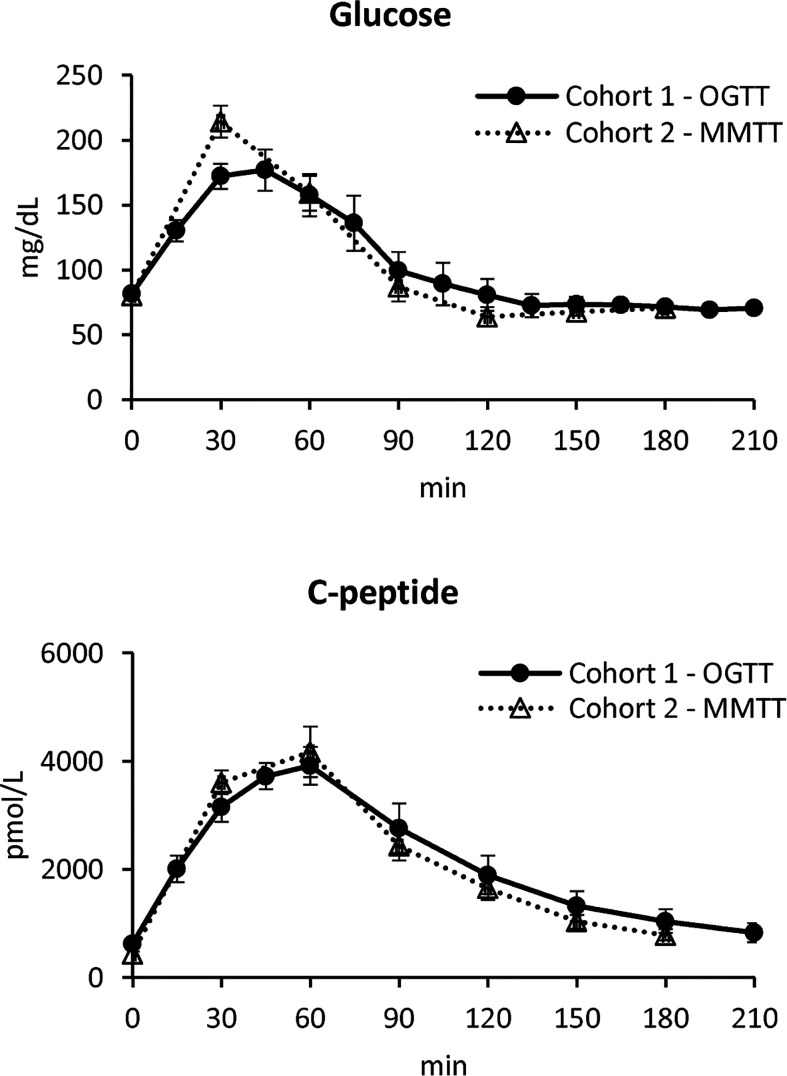
Plasma glucose (top) and C-peptide (bottom) concentrations in Cohort 1 – OGTT (continuous line with black circles) and Cohort 2 – MMTT (dotted line with triangles) (mean ± SE).